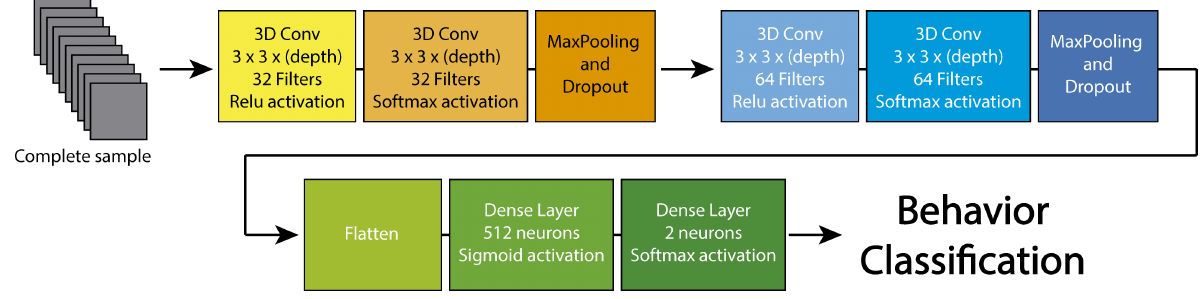
Figure 4. Architecture of the DL Model used for this investigation. The depth of the kernel for the 3D convolution is adjusted to 10, 30, or 90 frames, according to each particular experiment (see Section